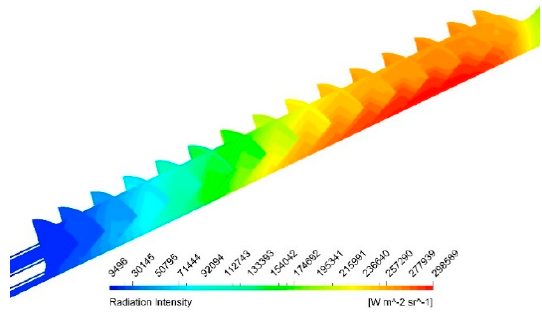
Energies 2020 , 13 , x FOR PEER REVIEW Figure 15. The WSGG model radiation intensity (50% axial scaling). Figure 15. The WSGG model radiation intensity (50% axial scaling).